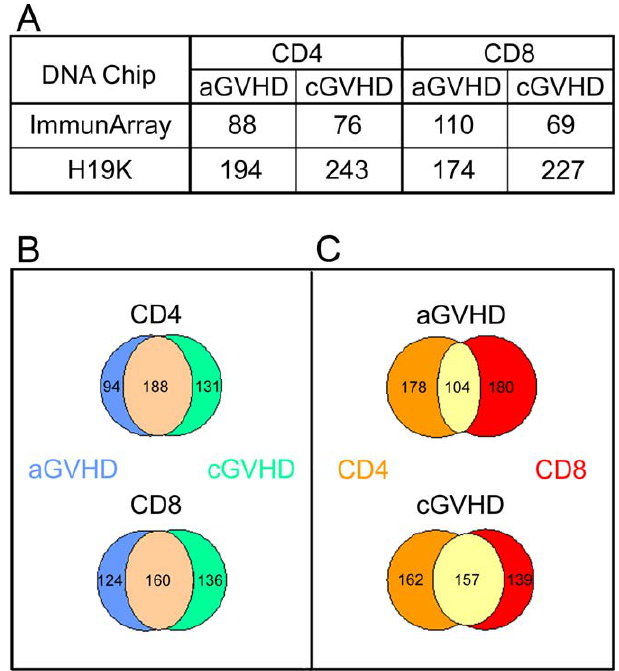
Figure 2. GVHD Predictive Genes Identified by One-Dimensional Analyses Searches were performed using two methods: a linear discriminant- analysis–based approach and statistical t-test. (A) Number of genes showing a GVHD-predictive accuracy (cid:5) 65% and p (cid:6) 0.05. (B and C) Data from the H19K and ImmuArray were pooled. Among GVHD-predictive genes, Venn diagrams represent counts relationships between CD4 þ versus CD8 þ T-cell gene profiles (B) and aGVHD versus cGVHD predictive-genes